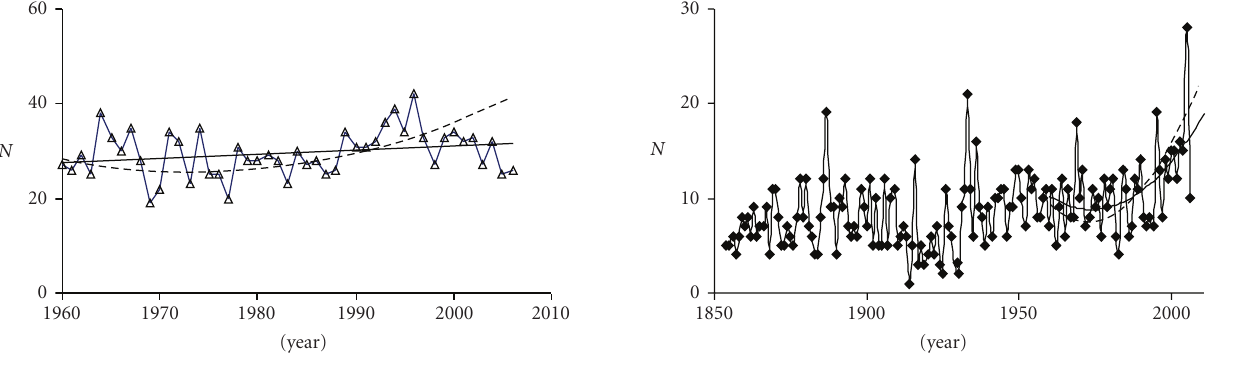
Figure 5: Number of storms predicted per year during the period 1960–2006 versus numbers actually observed for the North Asia basin (open triangles), and the nearly flat trend line fit to the data. The model predictions (dashed continuous curve) have been smoothed and have been normalized to the data.